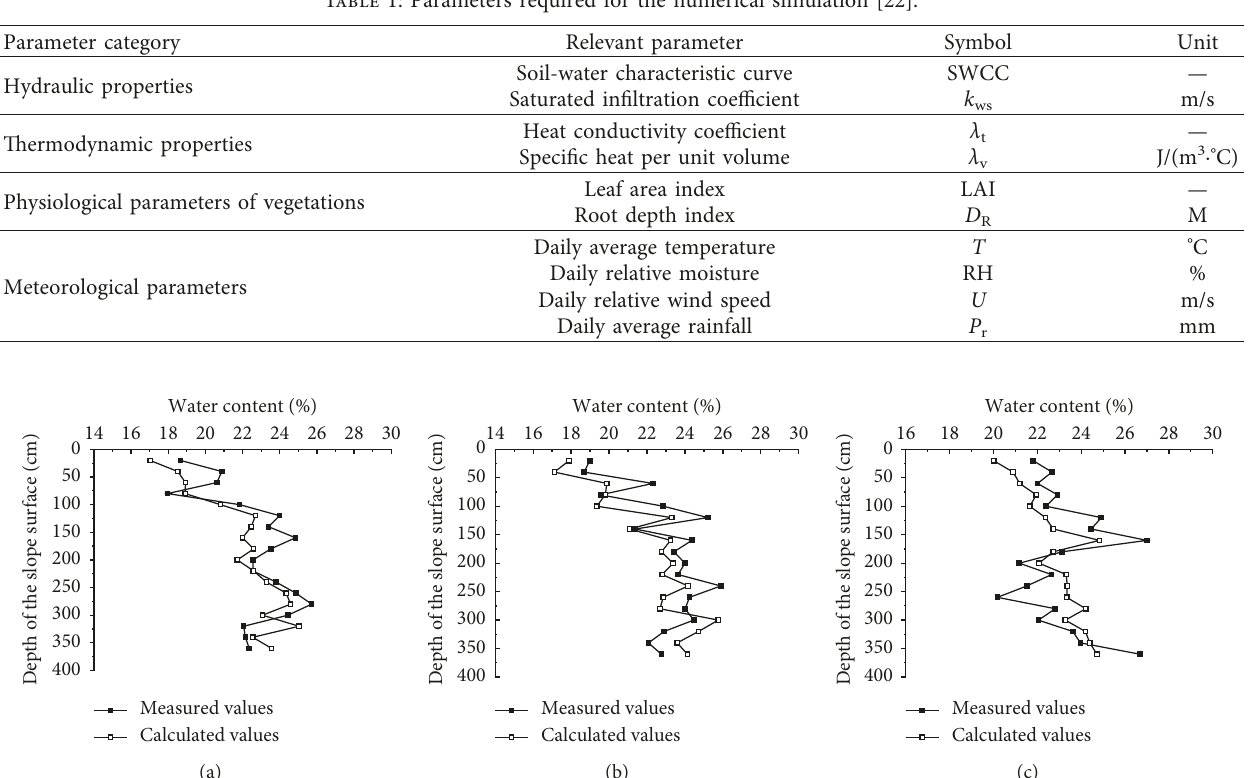
Figure 8: Estimated and measured degrees of compaction. Comparison of section: (a) V1; (b) V2; (c) Table 1: Parameters required for the numerical simulation [22].